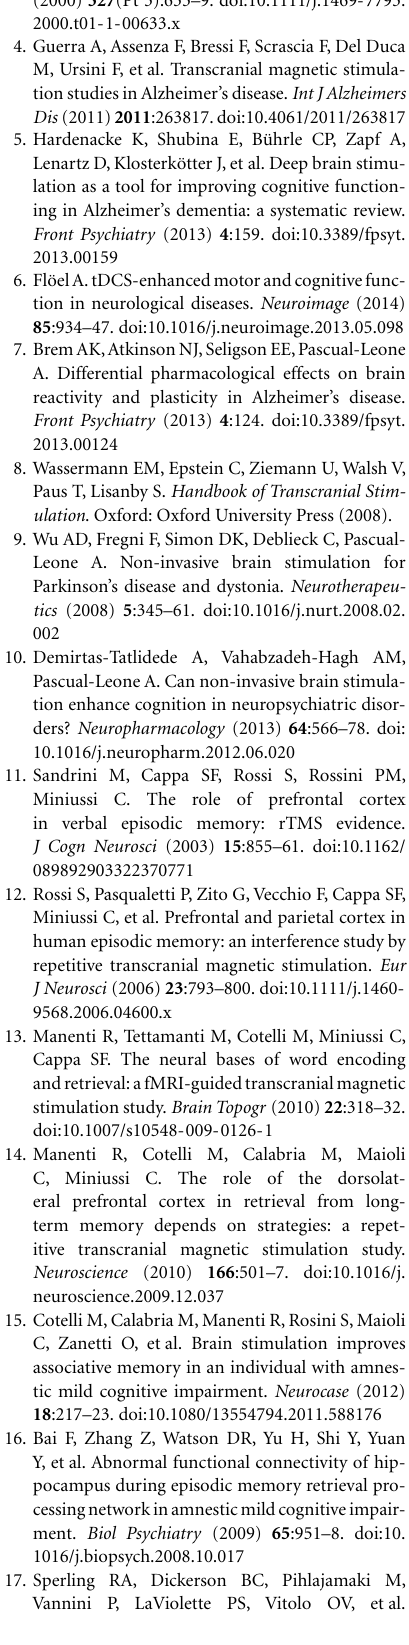
Table 1 | Brain stimulation inAlzheimer’s disease patients: stimulation sites and clinical effects